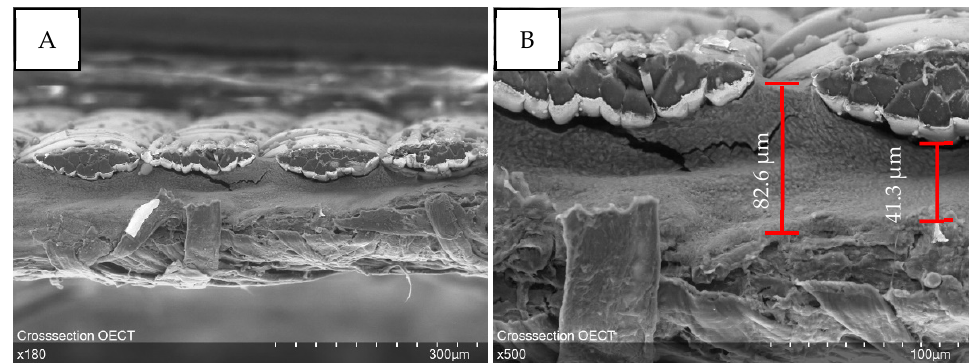
Figure 7. Cross-sectional examination of the layered OECT structure shows how the gate electrode and source/drain electrode are glued together by the electrolyte. ( A ): 180 times magnification. ( B ): 500 times magnification.